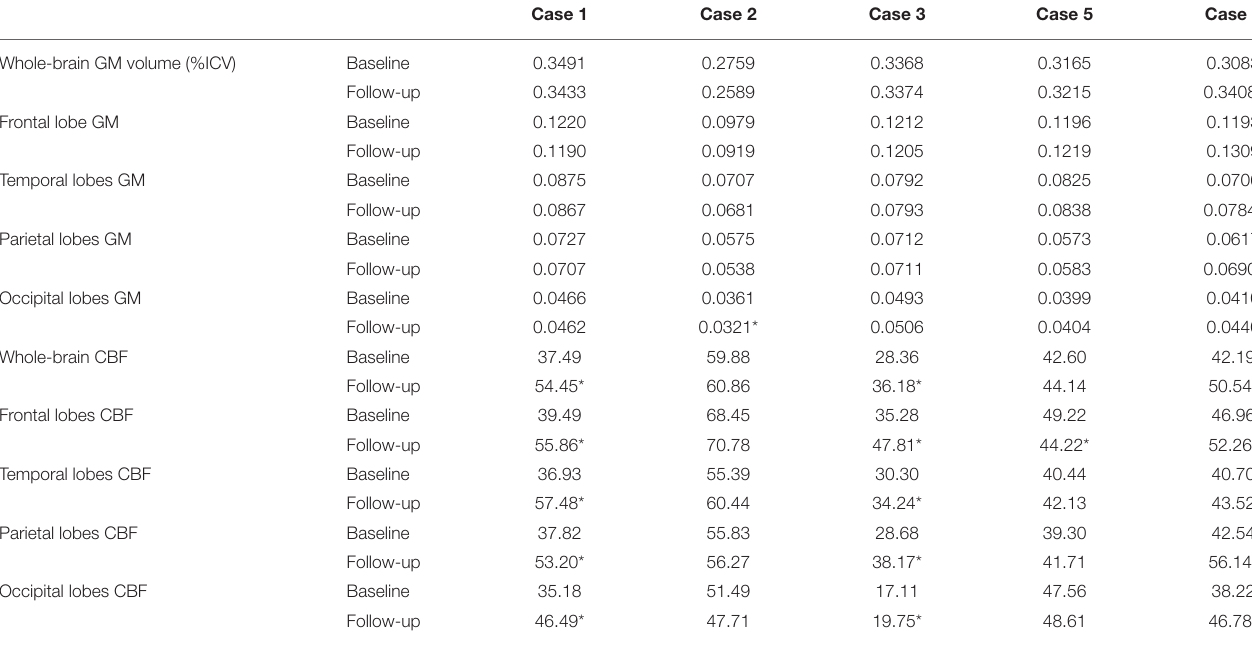
TABLE 5 | Whole brain and regional gray matter (GM) volume (% intracranial volume) and cerebral blood flow (CBF in ml/100g gm/min) for phenocopy frontotemporal dementia (phFTD) cases at baseline and follow-up. Case 1 Case 2 Case 3 Case